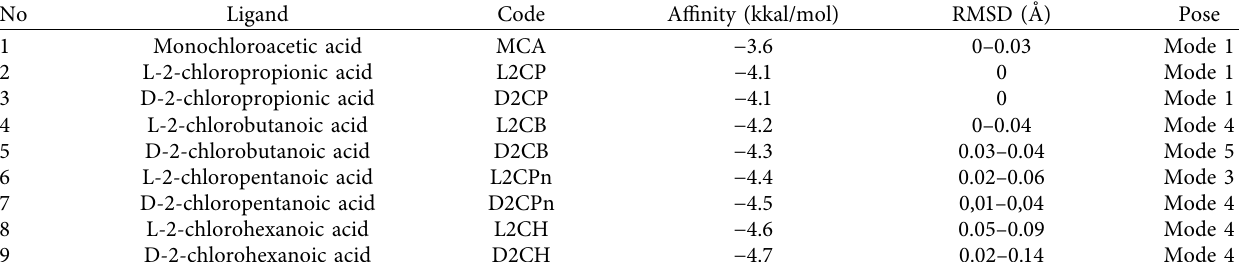
Table 5: Docking energy average of 2-chloroalkanoic acids in the active site of Bcfd1.